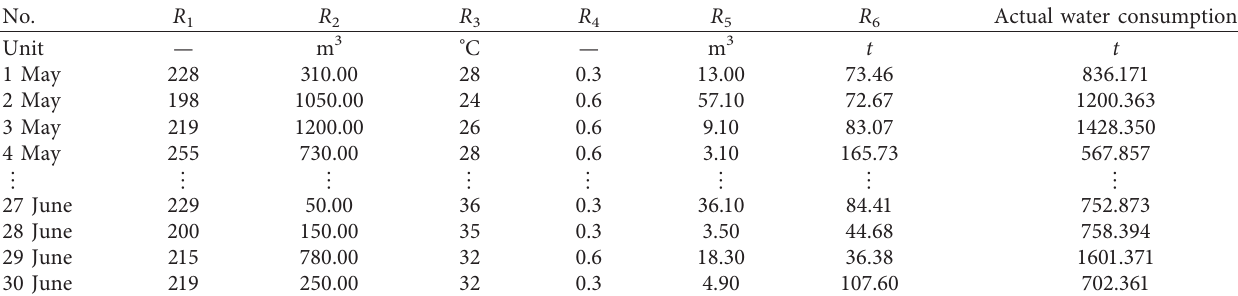
Table 1: Numerical value of each factor and actual water